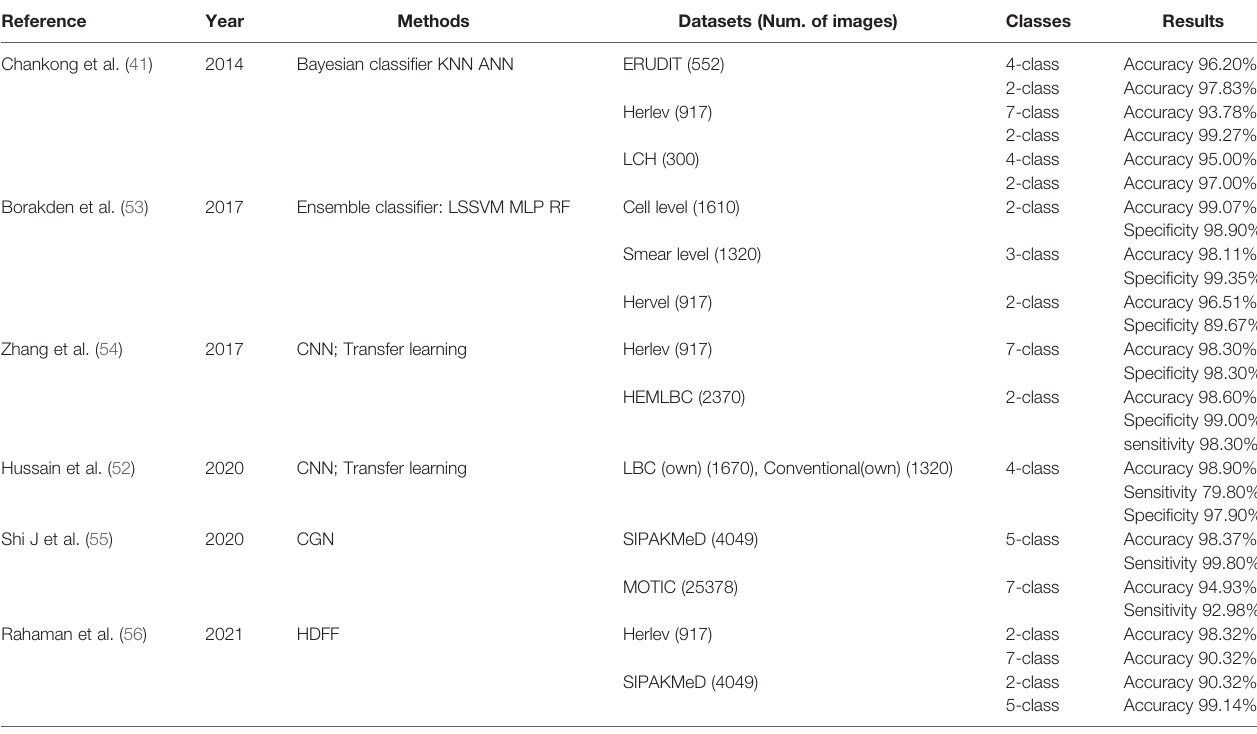
TABLE 4 | Application of AI in cervical cell classi fi cation. Reference Methods Datasets (Num. of